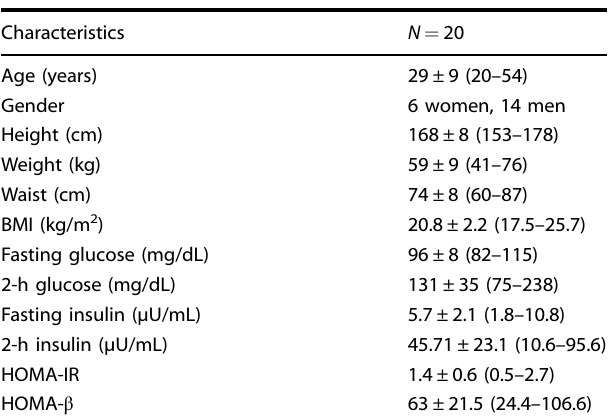
Table 1. Characteristics of